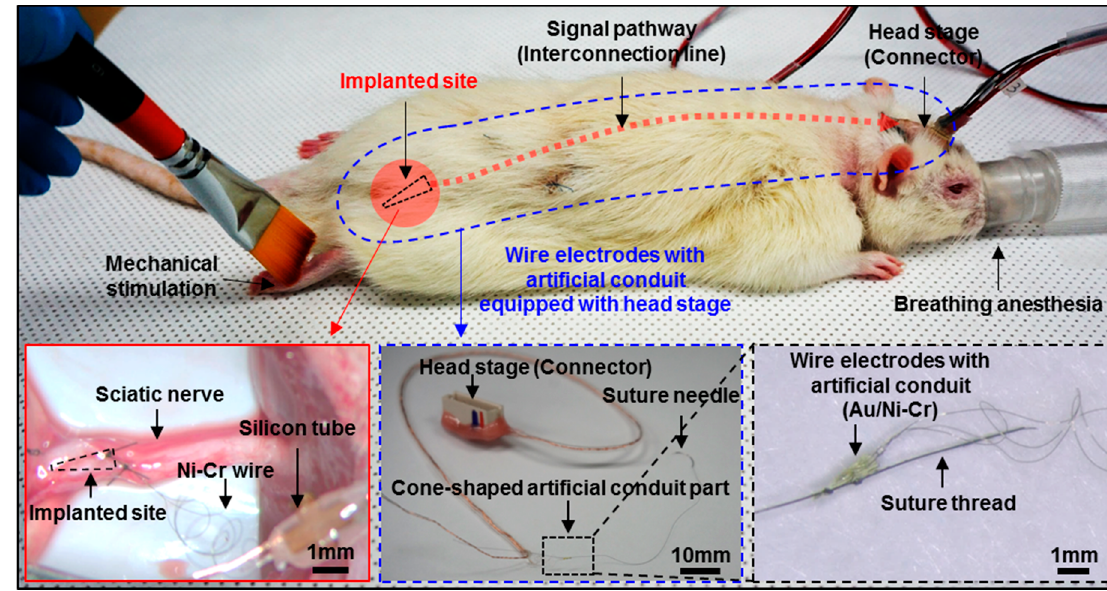
Figure 5. Overall in vivo images of wire electrodes with the artificial conduit. Implantation and neural signal measurement of fabricated neural electrodes with the artificial conduit. NFM DAPI Fibronectin Merge